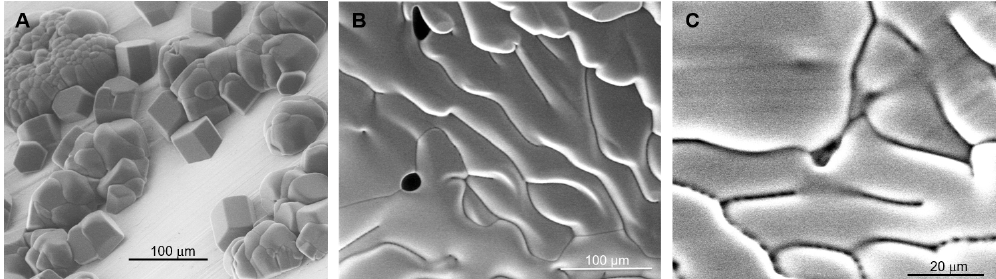
Figure 4. (a) Hexagonal pillars of isolated crystals and polycrystalline ice films grown on an oxidized copper surface. ESEM imaging conditions: P = 135 . 1Pa, T = − 17 . 8 ◦ C, P sat = 127 . 4Pa, and h = 1 . 06. (b) Typical polycrystalline ice surface after growth and coalescence of the crystals on Si. The grains appear bright with typical shading effects. They are limited by 1 to 2µm wide dark bands (“grooves”). Three grooves meet at angles of mainly 90 to 120 ◦ . Each groove consists of aligned pores of ≈ 1–3µm in diameter. P = 438 . 4Pa, T = − 4 . 8 ◦ C, P sat = 409 . 0Pa, h = 1 . 07. (c) Polycrystalline ice surface during growth. Circular pores aligned along grooves. P = 287 . 3Pa, T = − 10 . 3 ◦ C, P sat = 253 . 3Pa, h = 1 .